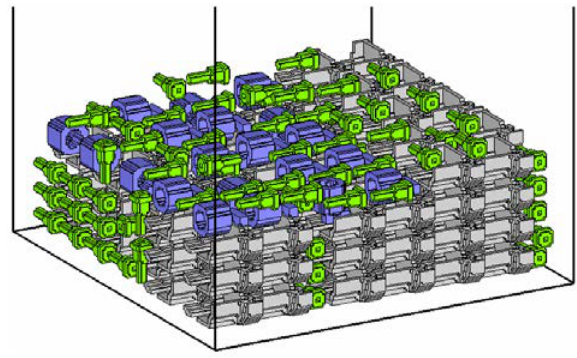
Fig. 11. The best placement obtained by Materialise Magics .